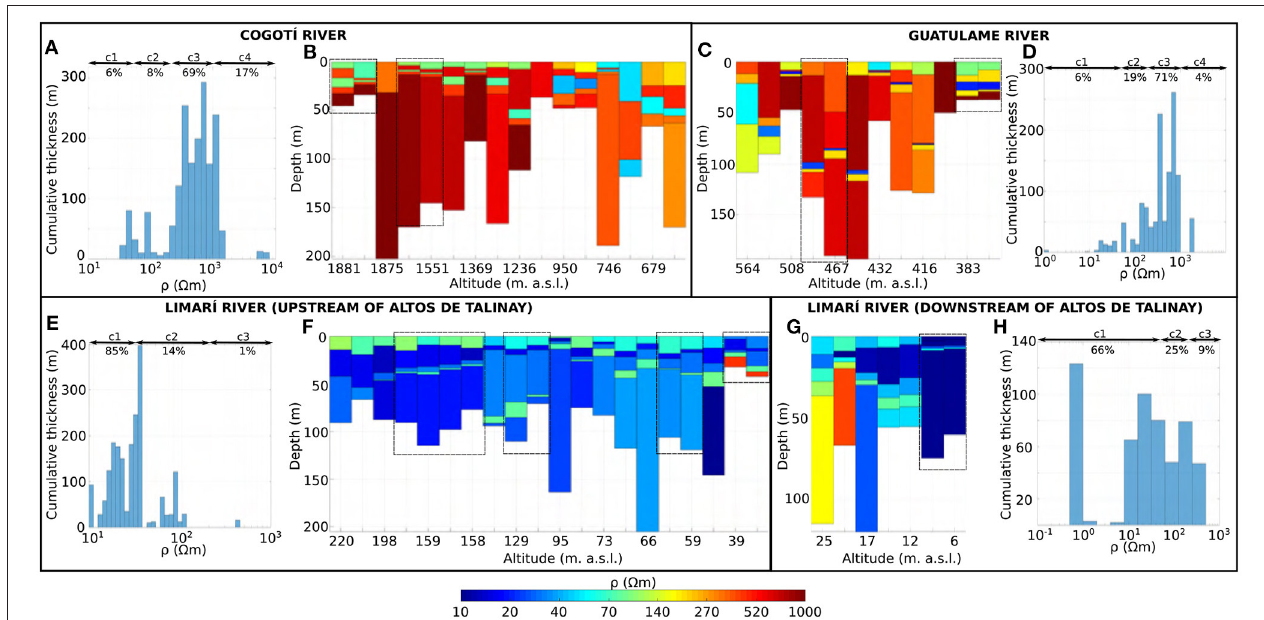
FIGURE 7 | Example of the inverted TEM resistivity results for four sectors of hydrogeological continuity. For each sector are displayed the cumulative resistivity thickness histograms (A,D,E,H) and the inverted 1D resistivity profiles in a decreasing topographic order (B,C,F,G) . Within the dashed-line boxes are represented resitivity profiles belonging to the same transect. The sectors displayed are Cogotí (A,B) , Guatulame (C,D) , and Limarí river upstream (E,F) and downstream (G,H) of Altos de Talinay. Layers with thickness significantly smaller than 10% of their depths should be considered with